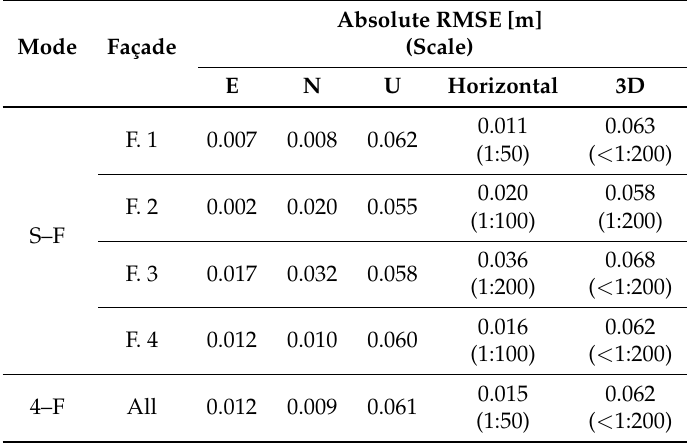
Table 7. Absolute Root Mean Square Errors (RMSE)–NRTK dataset. The scale whose metric survey specifications were satisfied is also reported in brackets.